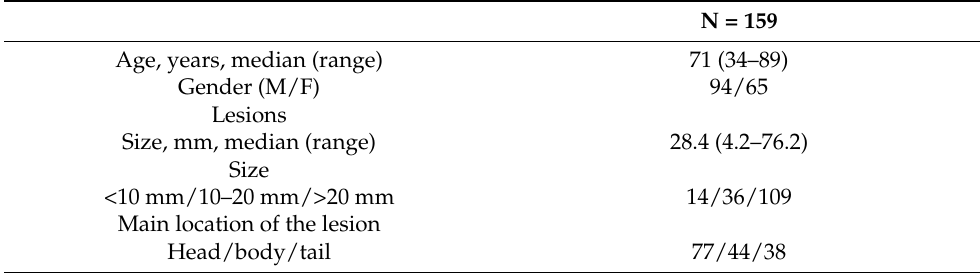
Table 1. Baseline characteristics of the patients and the targeted